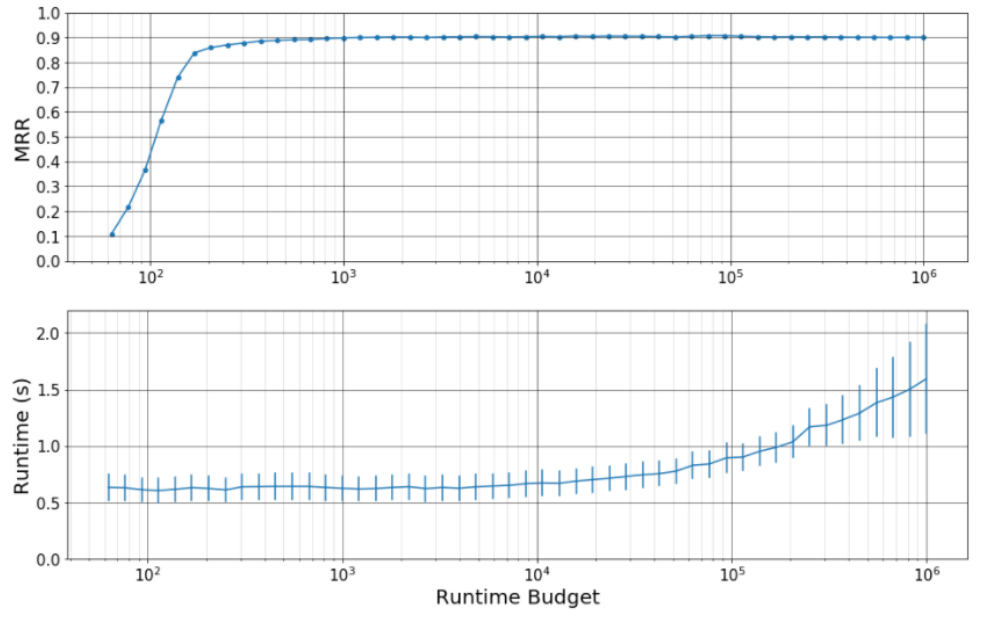
Figure 6. The effect of runtime budget on retrieval accuracy ( top ) and average runtime ( bottom ) for the marketplace system. The bars in the lower plot indicate one standard deviation above and below the